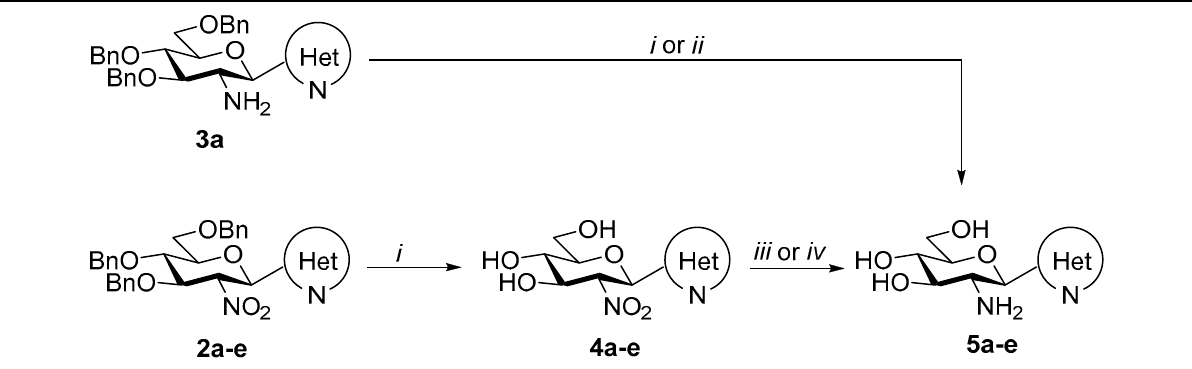
Table 2. Synthesis of C -(2 ′ -amino-2 ′ -deoxy- β - D -glucopyranosyl)azines.